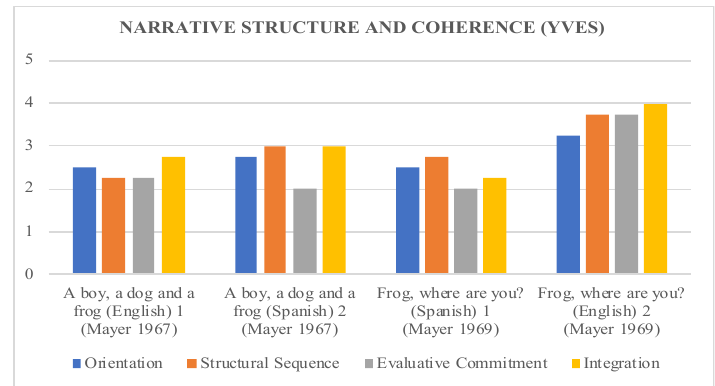
Figure 5. Yves’ scores for the narrative structure and coherence dimension. Figure 5 . Yves’ scores for the narrative structure and coherence dimension. Figure 5 . Yves’ scores for the narrative structure and coherence dimension.